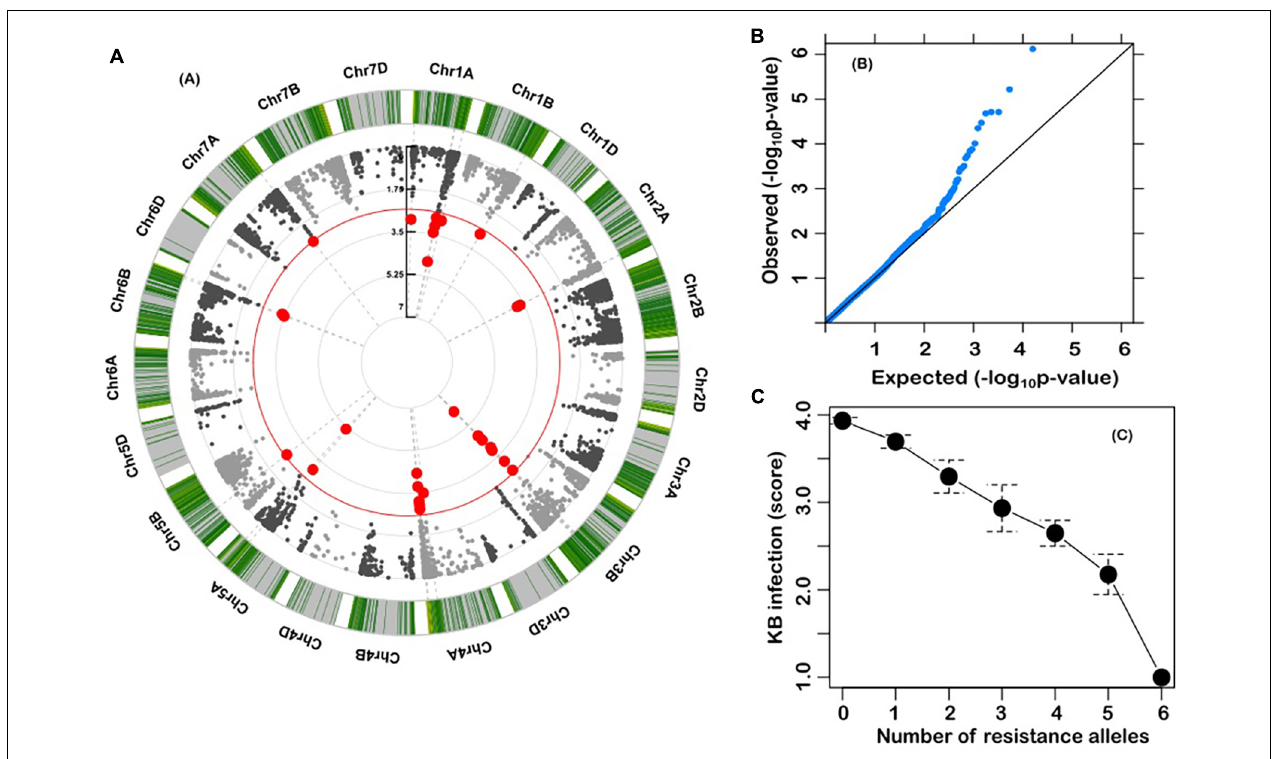
FIGURE 3 | (A) Circular Manhattan plot from genome-wide scan with a mixed linear model. The red line is the significance threshold; (B) QQ plots from genome-wide scan. The late separation between observed and expected P-values in the upper left section represents the significant associations; and (C) Relationship between number of favourable alleles and Karnal bunt resistance in the wheat accessions.